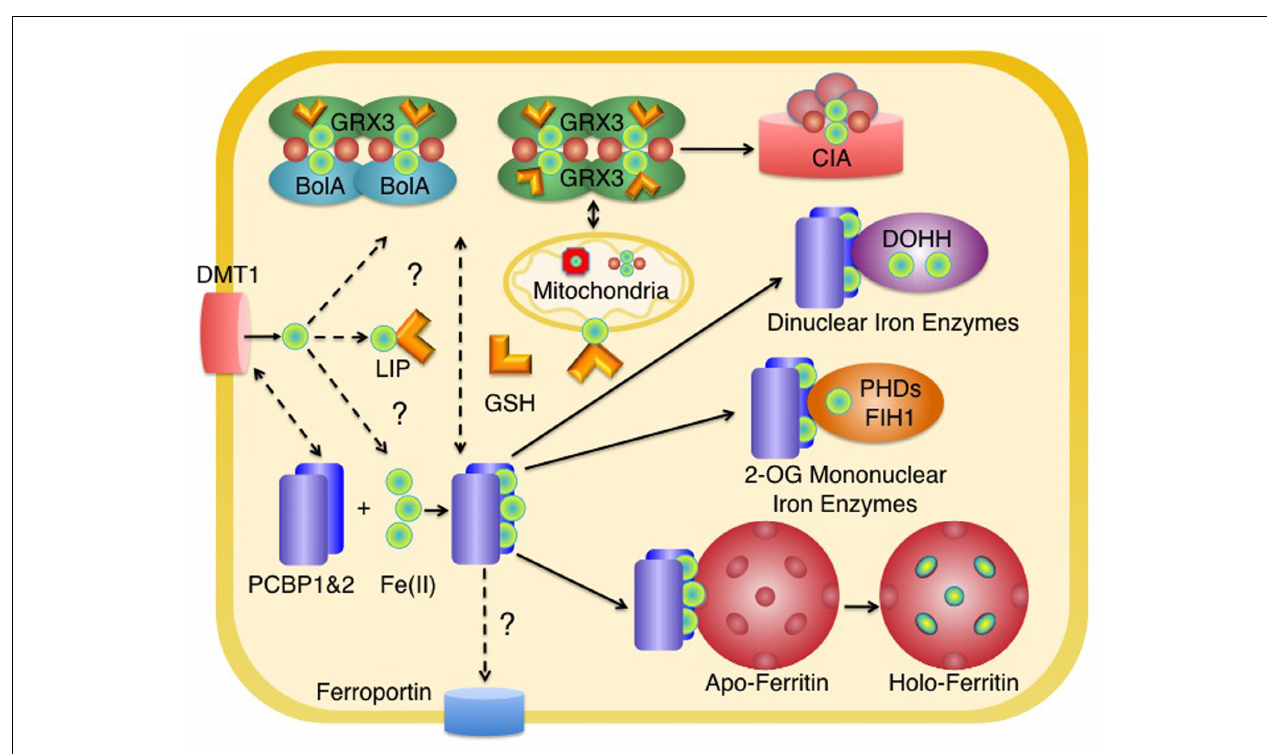
bind iron in the cytosol and deliver it to target non-heme iron enzymes, such as ferritin, 2-oxoglutarate-dependent dioxygenases (mononuclear iron enzymes such as PHD2 or FiH1), and oxo- or peroxo-bridged diiron oxygenases (dinuclear iron enzymes such as DOHH). The source of iron for PCBPs is not known, but could include components of the LIP coordinated by GSH or iron coordinated by Grx3. PCBP2 may directly acquire iron from transporters such as DMT1 and may also deliver iron to ferroportin for efflux. Some intracellular organelles have been omitted for clarity. Red spheres indicate inorganic sulfide as part of an Fe–S